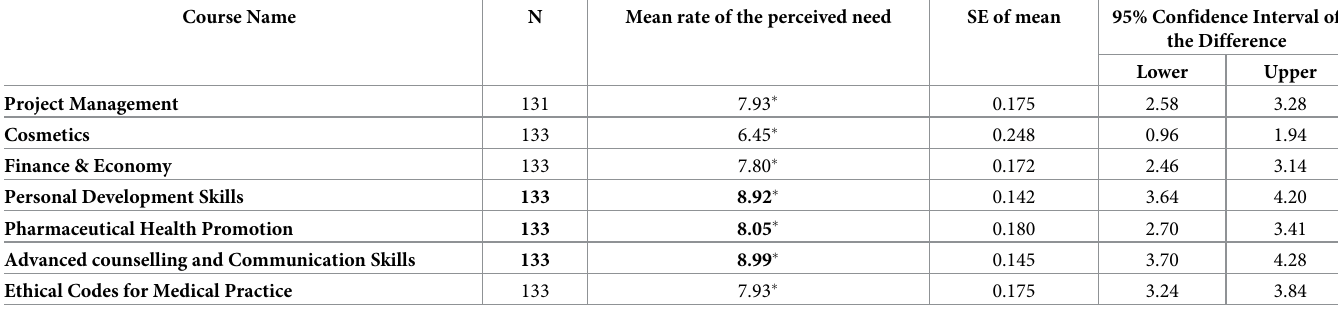
Table 7. RMS Pharmacist views on